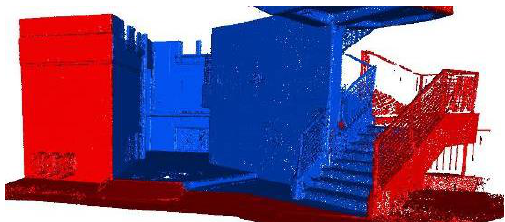
Figure 13 . Point cloud showing the not considered portion (red colour) and the considered portion (blue colour) for the clod-to- cloud distance analysis.